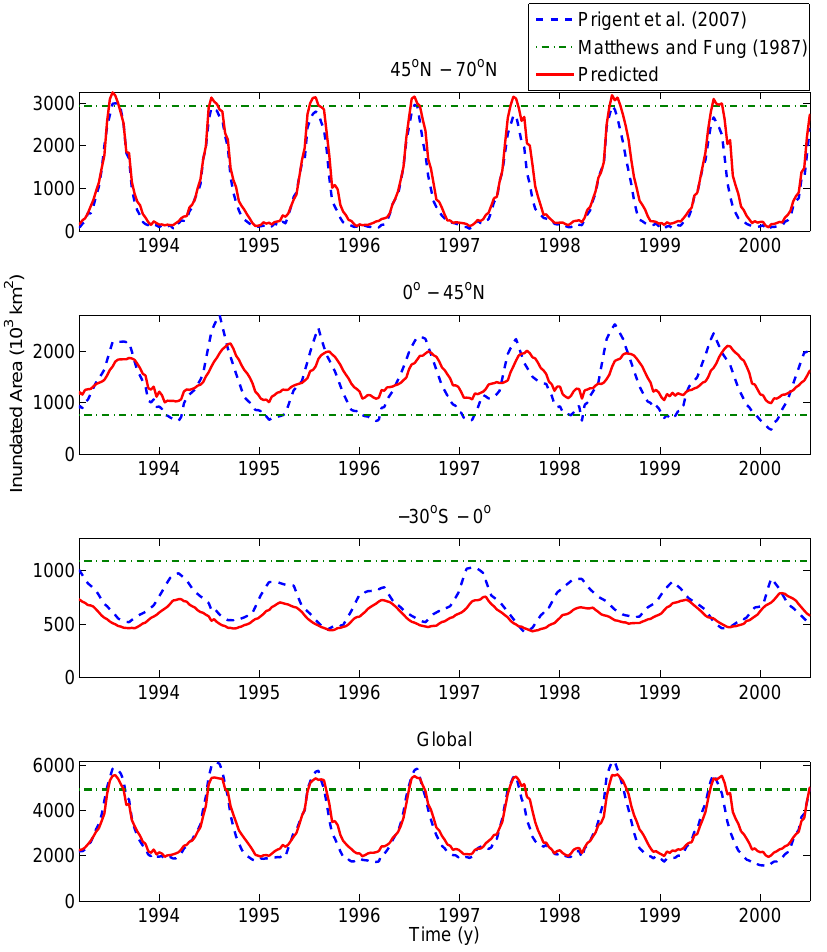
Fig. 2. F i for three latitude bands and globally estimated from three approaches: satellite reconstruction (Prigent et al., 2007); the approach described in Matthews and Fung (1987), and the approach integrated in